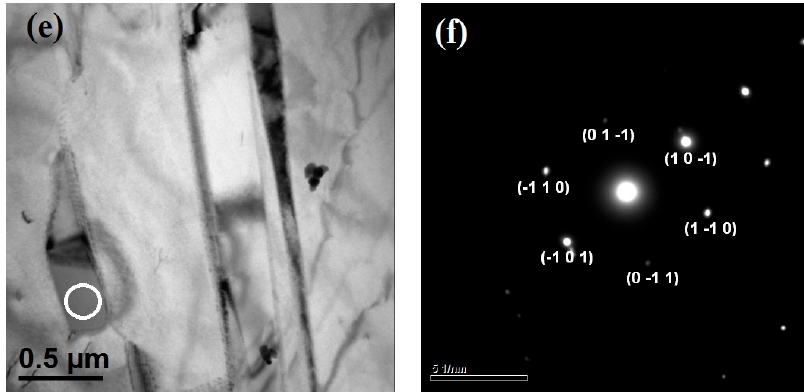
Figure 9. Bright field transmission electron microscopy (TEM) image of ( a ) γ ( c ) α 2 and ( e ) β phase and the corresponding selected area electron diffraction( SAED) pattern taken from ( b ) [ − 1–1 2] ( d ) [0–1 0] and ( f ) [1 1 1] zone axis, respectively.